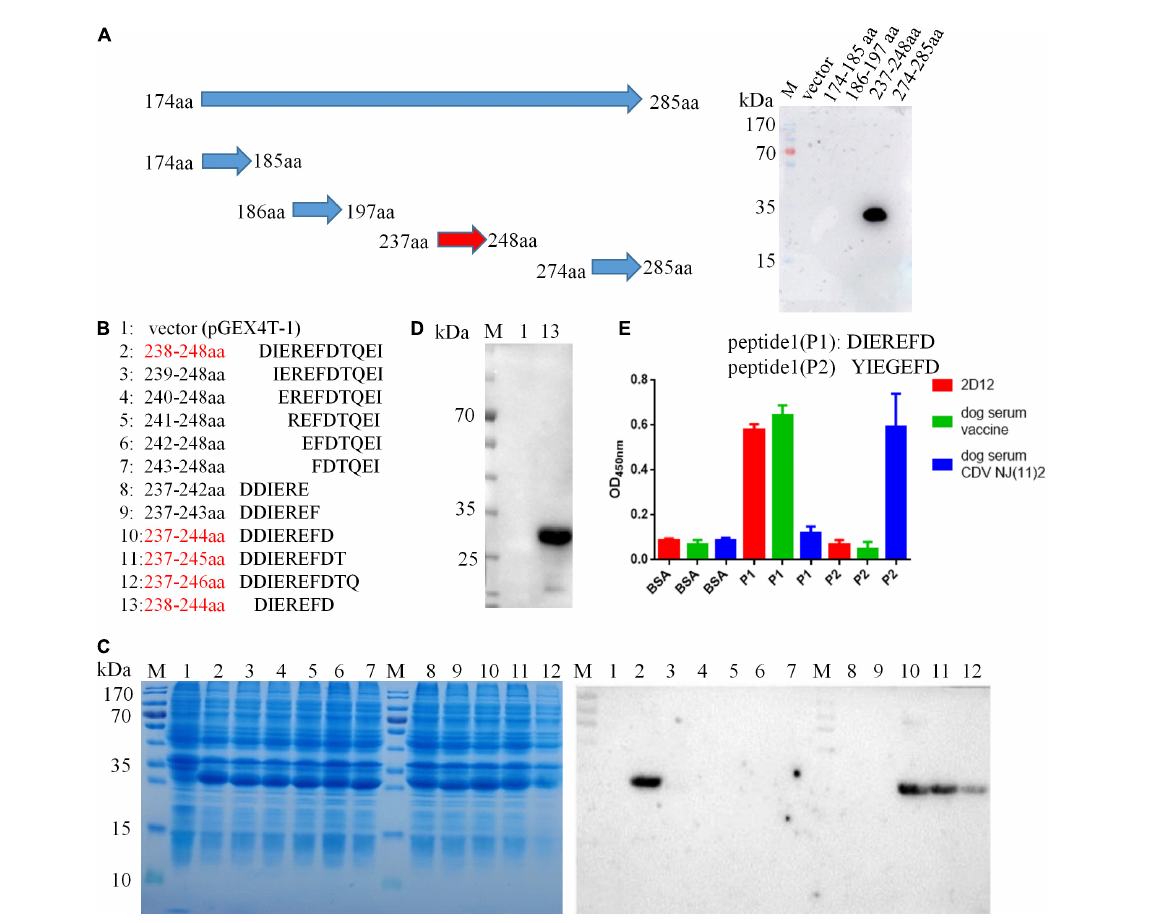
FIGURE3 Epitope identification of mAb 2D12 by western blot. (A) Schematic representation of truncated H proteins of canine distemper virus (CDV) and identification of the reactivity of mAb 2D12 with truncated H fragments by western blot. (B) Amino acid sequences of different truncated proteins. The red text color indicated the positive reactivity of the truncated proteins with mAb 2D12. (C) The expression of different truncated H proteins was identified by SDS-PAGE and the reactivity of mAb 2D12 with different truncated H proteins was identified by western blot. (D) The reactivity of mAb 2D12 with the identified antigen epitope (238DIEREFD244) was identified by western blot. (E) Serological test for the identified epitope by ELISA. The reactivity of antigen epitope (238DIEREFD244 or 238YIEGEFD244) with mAb 2D12 and dog sera against vaccine or CDV NJ(11)2 strain was identified by ELISA. Means ± S.D. of data from three independent experiments performed are shown.